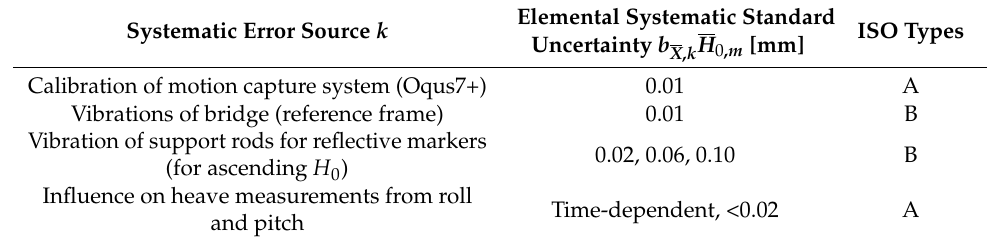
Table 3. Classification and quantification of systematic errors.